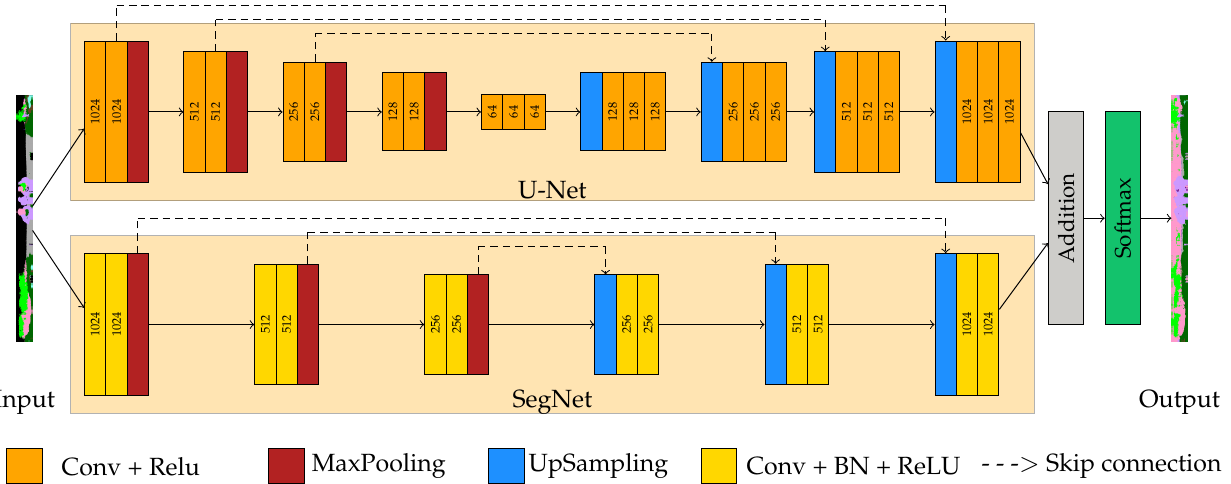
Figure 5. An illustration of a SegUnet3D architecture. The 64 × 1024 image is in two streams, downsampling in the encoder and then upsampling in the decoder. Thus, the input and output size will be the same. The specified numbers represent the width of the image in that